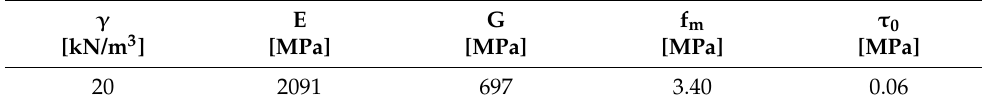
Table 5. Mechanical properties of the masonry after the retrofitting interventions.